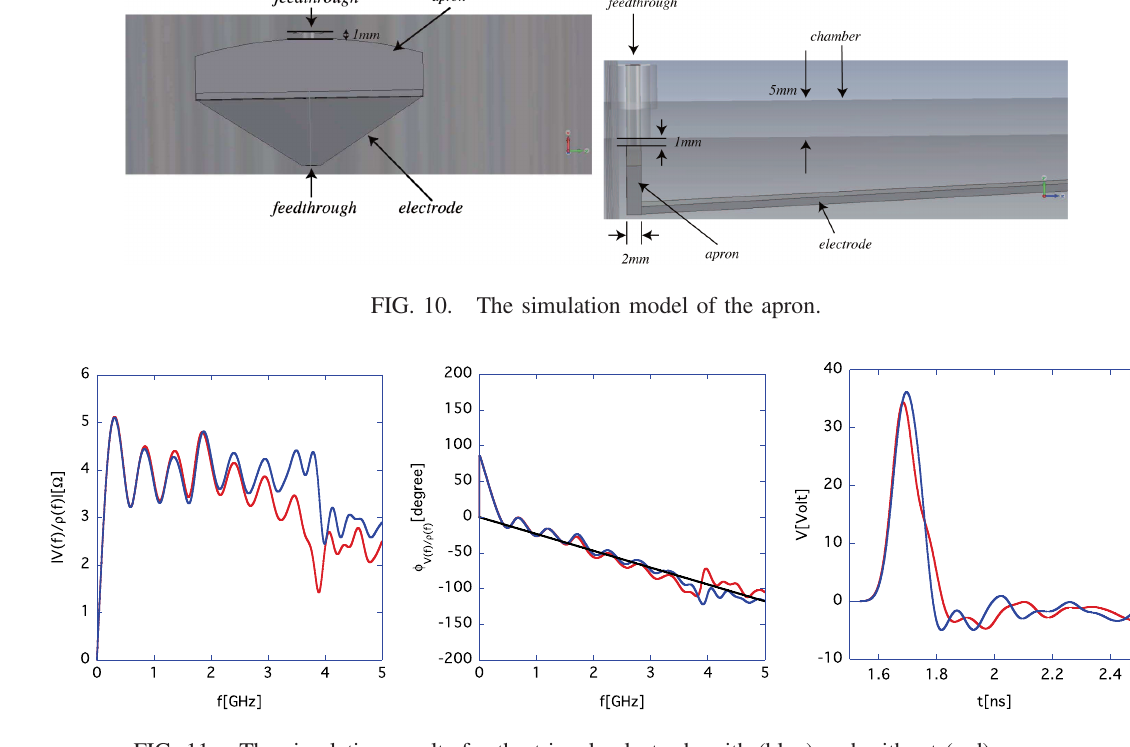
FIG. 11. The simulation results for the triangle electrode with (blue) and without (red) apron.